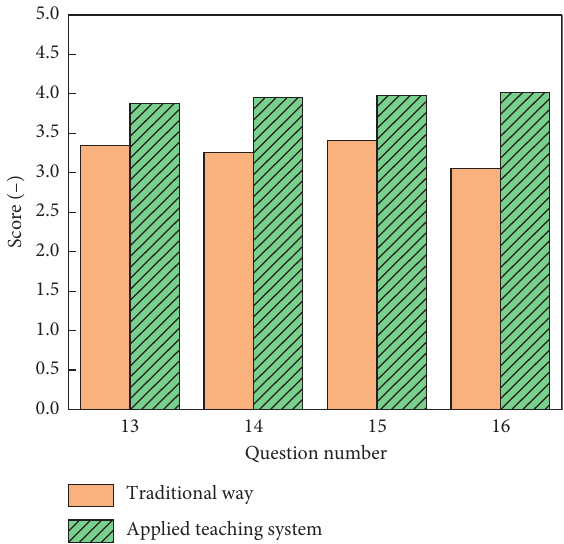
Figure 11: The scores of I&P teaching satisfaction.